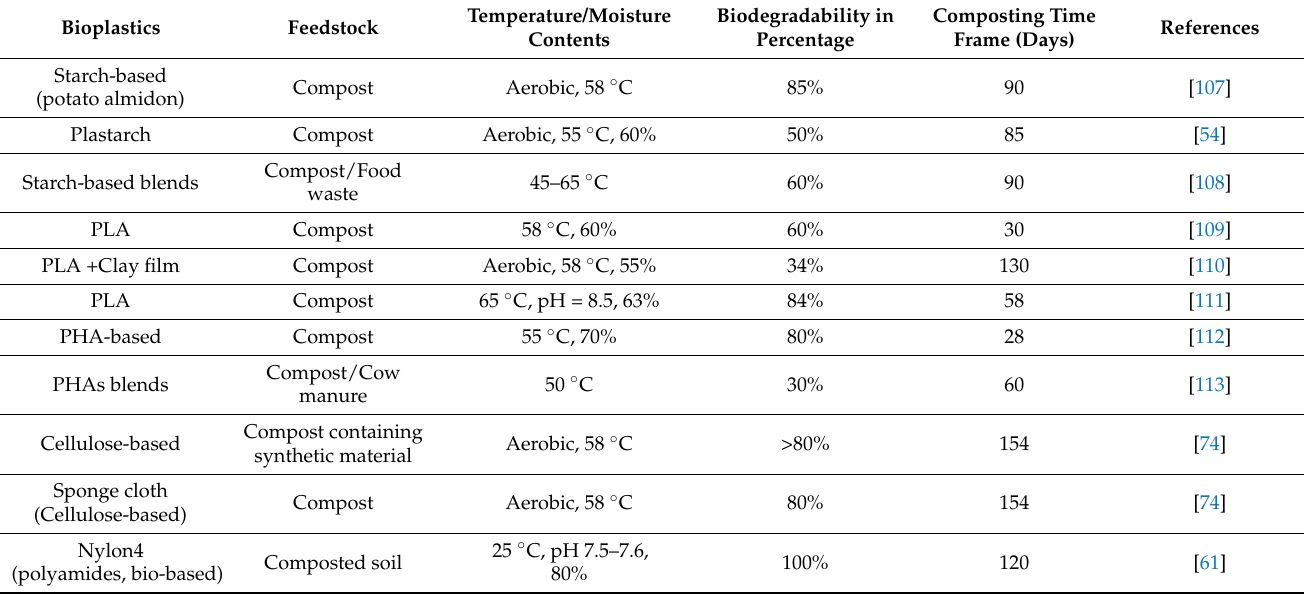
Table 2. Biodegradation of different types of bioplastics in